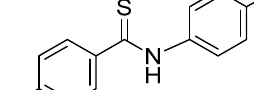
Figure 3. Structure of the thiobenzanilides showing antiproliferative activity against estrogen- dependent MCF-7 cancer cells [22].